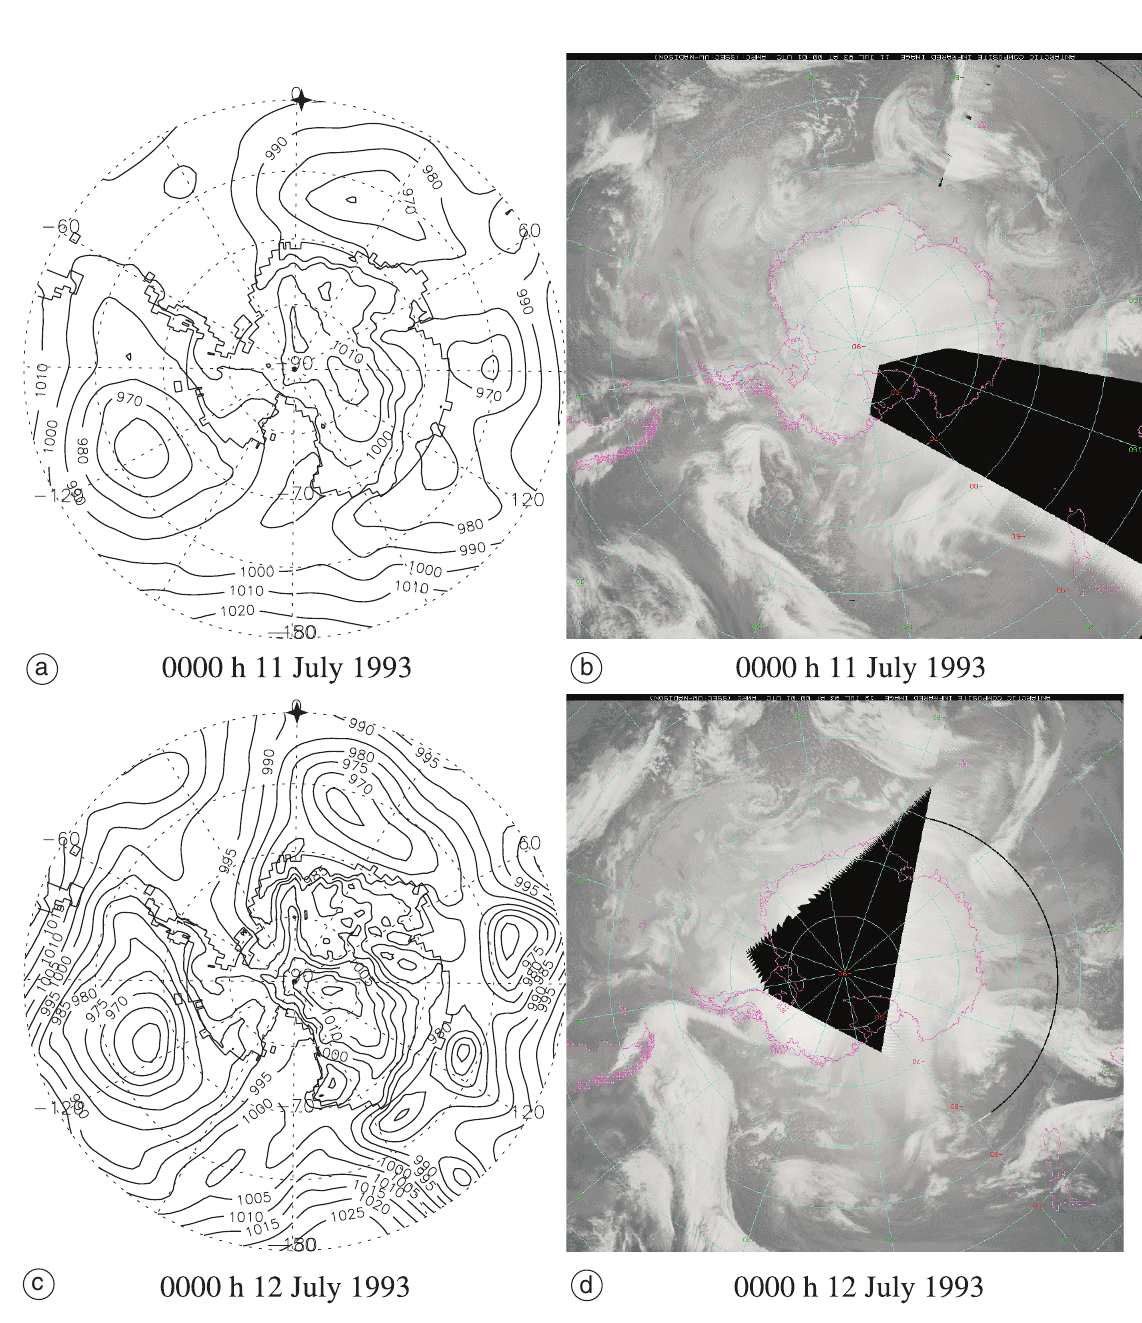
Fig. 7a-d. ECMWF analyses of mean sea level pressure charts and composite infrared satellite images for 0000 h 11 July (a,b) and 0000 h 12 July 1993 (c,d),